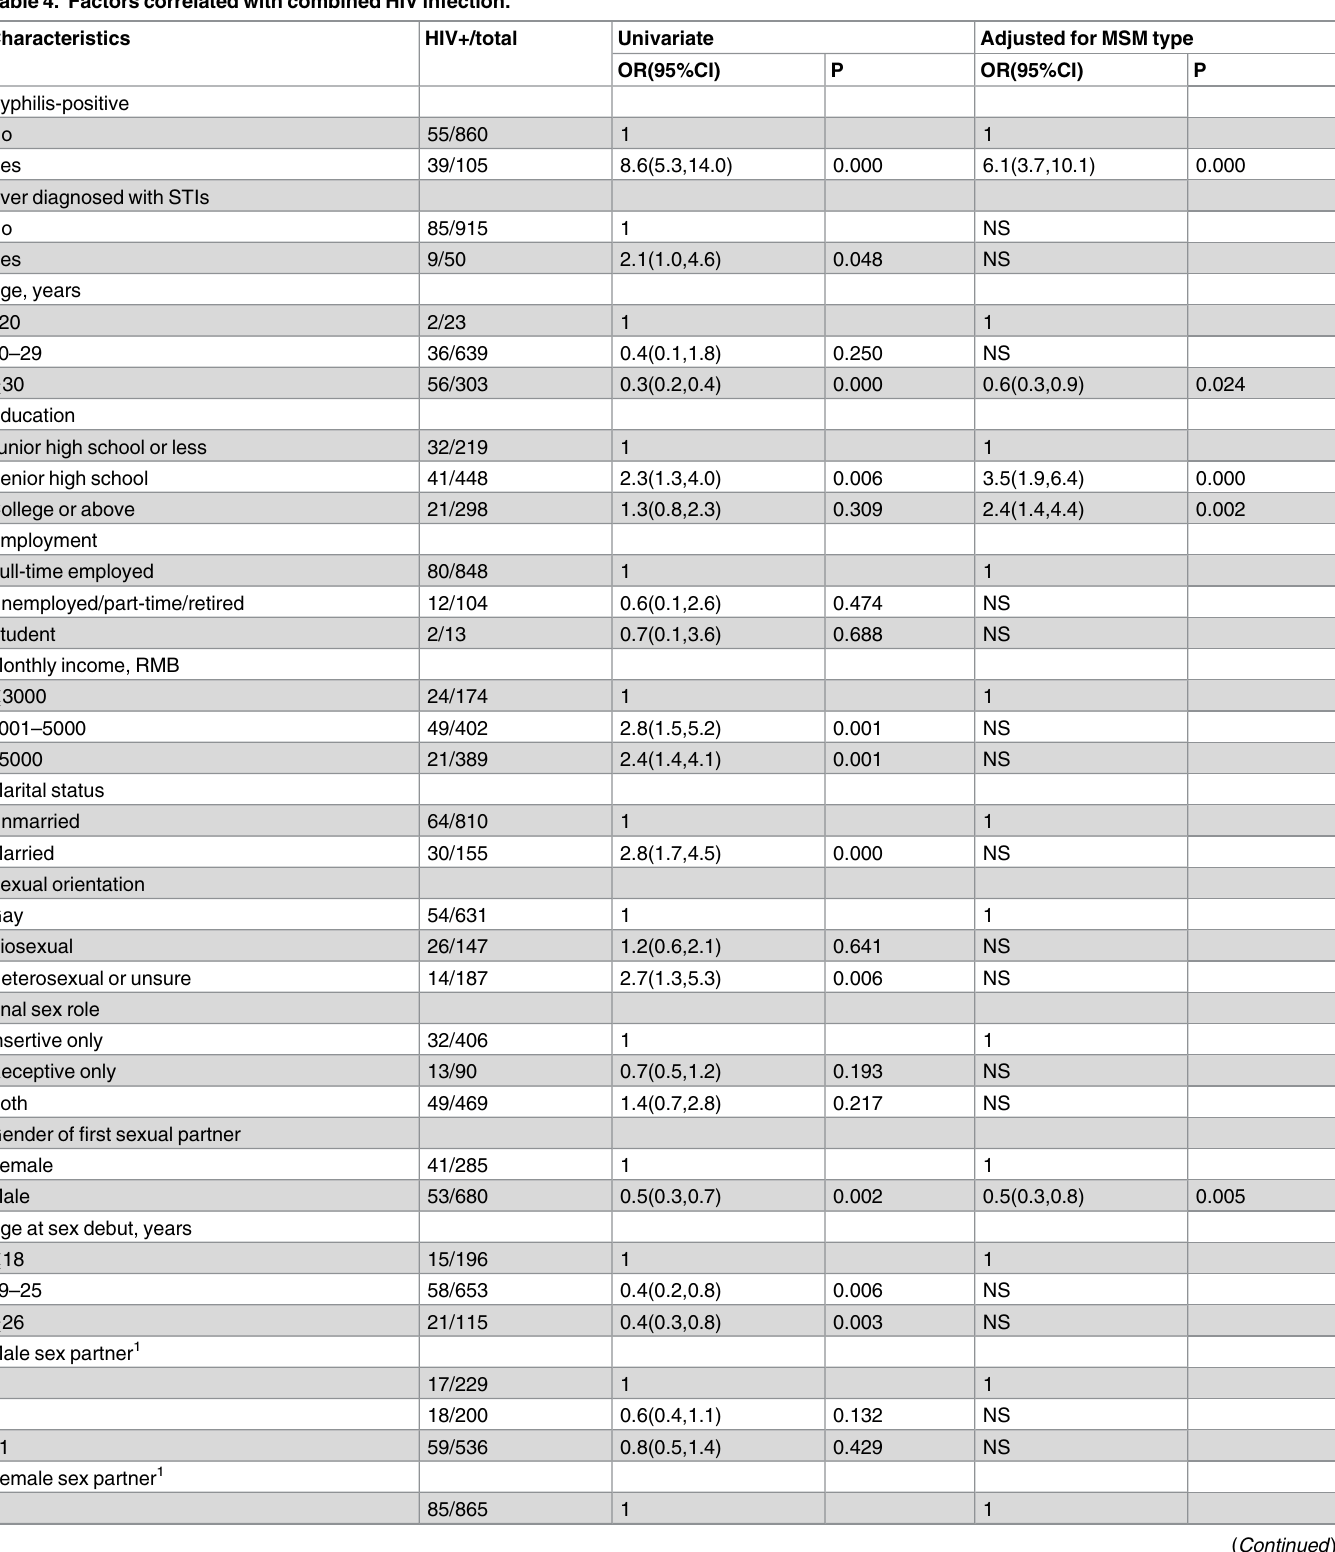
Table 4. Factors correlated with combined HIV